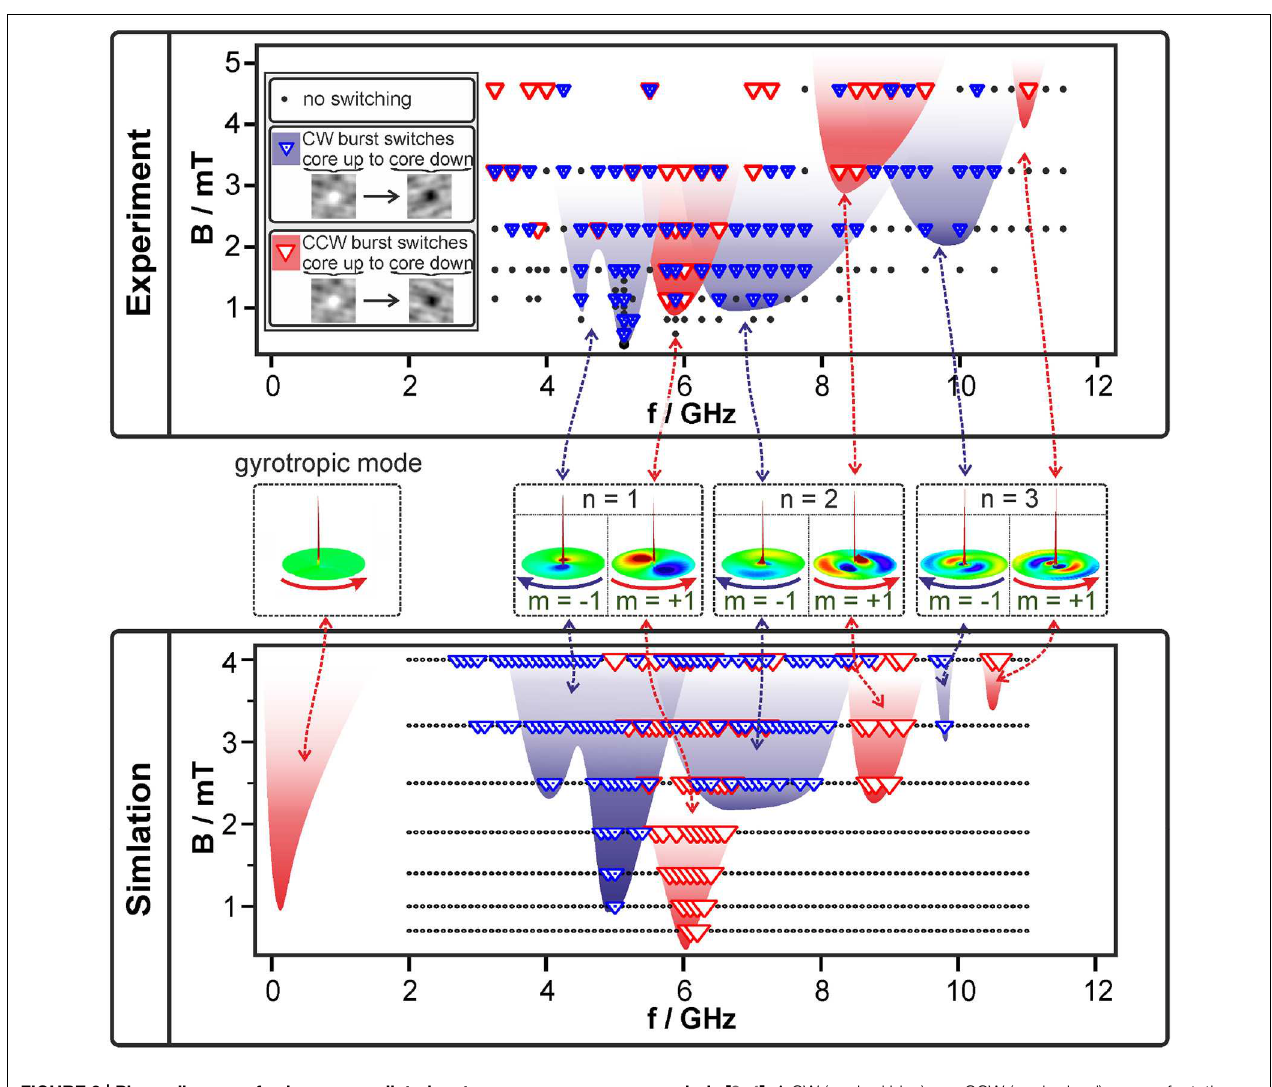
FIGURE 3 | Phase diagram of spin wave mediated vortex core reversal: switching amplitude versus excitation frequency for excitation with rotating external magnetic fields with a duration of 24